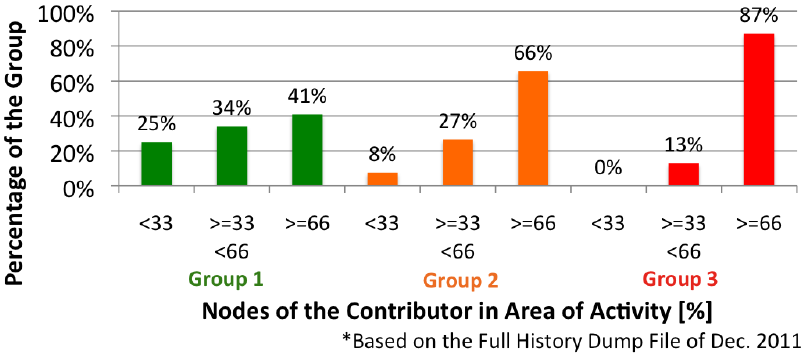
Figure 14. Nodes of a contributor in area of